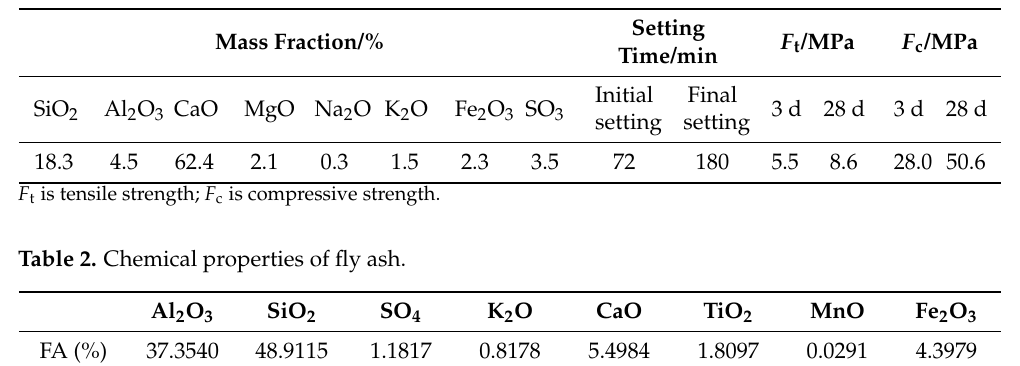
Table 3. The main characteristics of PVA.